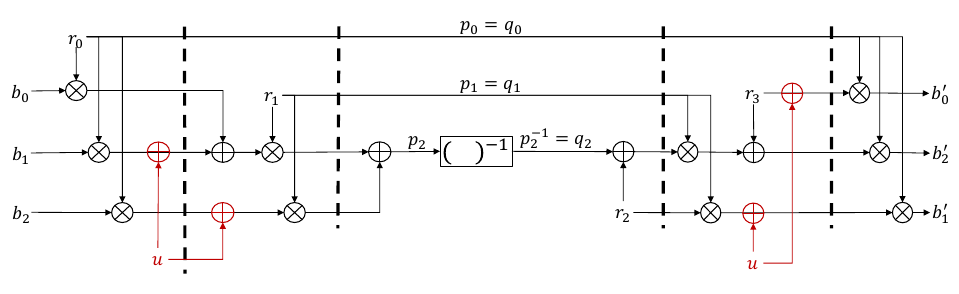
Figure 3: Second-order shared implementation of an inversion in F q . The dashed lines depict